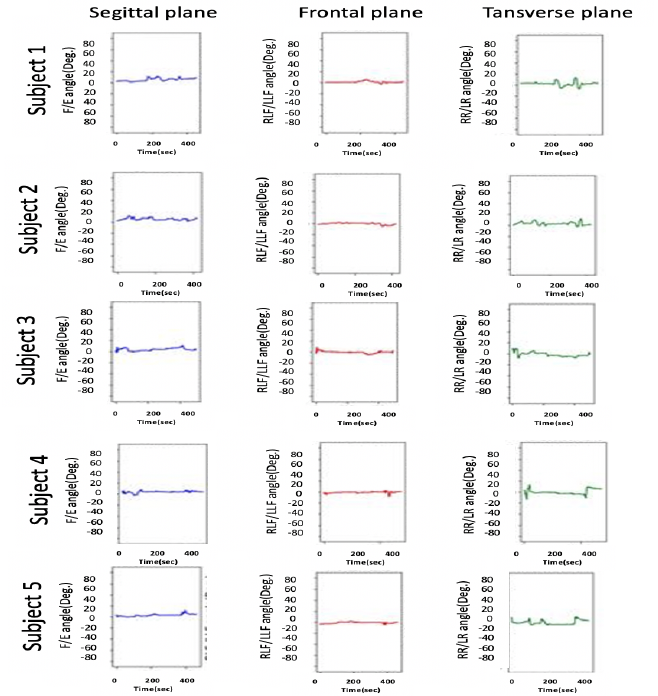
Figure 16. Head movement for typically developing